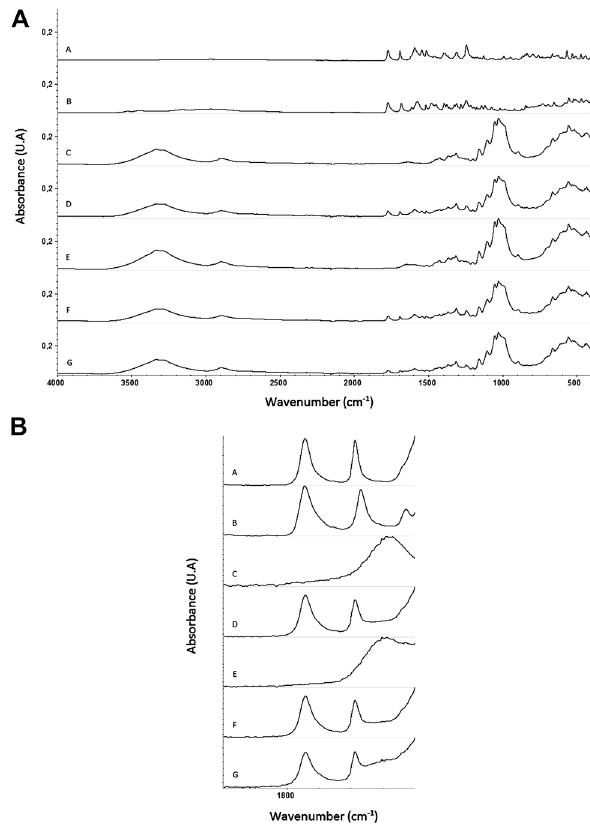
Figure 1: (a) ATR-FTIR spectra of (A) AS, (B) ATH USP standard, (C) MCC as individual components, (D, E) AS dosage forms immediately aftercompoundingandafter25daysofstorageat40 ° C/75%HR,(F, G) ATH dosage forms immediately after compounding and after